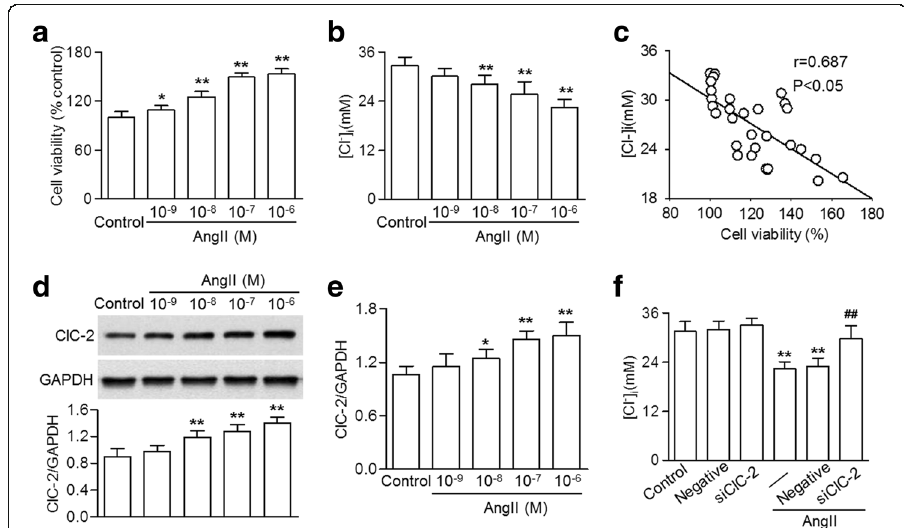
Fig. 1 ClC-2 knockdown inhibited the AngII-induced efflux of Cl − in HBVSMCs. a HBVSMCs were treated with angiotensin II (AngII) at different concentrations (10 − 9 , 10 − 8 10 − 7 and 10 − 6 M) for 48 h. Cell viability was determined using the CCK-8 assay. b Intracellular Cl − concentration [Cl − ] i was examined using an MEQ fluorescence probe. c The correlation between [Cl − ] i and cell viability was analyzed. d and e – The expression of ClC-2 in the cells treated as described in ( a ) was examined using western blotting ( d ) and quantitative real-time PCR ( e ). f Cells were treated with ClC-2 siRNA (20 nM) or negative siRNA for 48 h before AngII incubation (10 − 7 M) for a further 48 h. [Cl − ] i was examined. * p <0.05, ** p <0.01 vs. control, ## p <0.01 vs. AngII alone, n